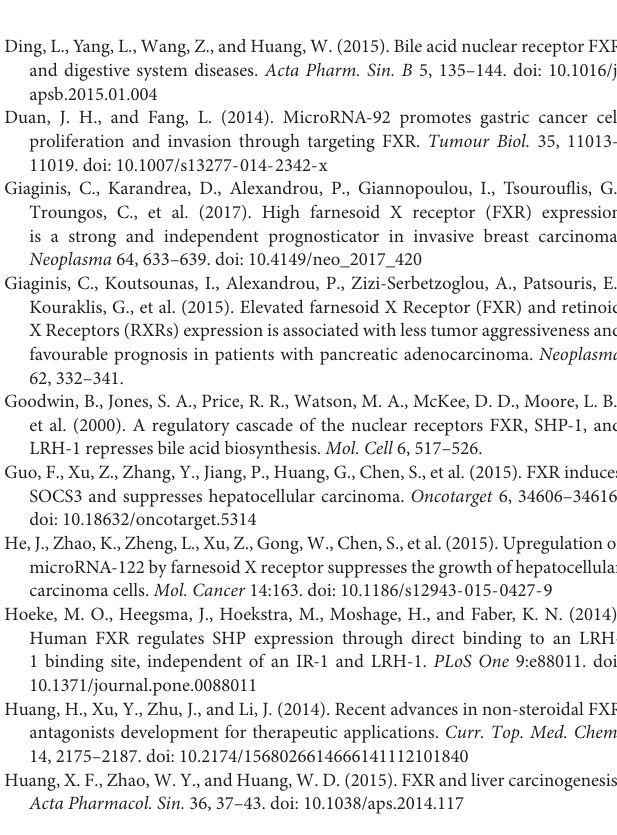
Supplementary Figure 1 | (A) Schematic of GV238 firefly luciferase vector. (B) LRH-1 site in the -122/-69 region of the SHP promoter. Supplementary Figure 2 | The pathway of FXR-mediated p53